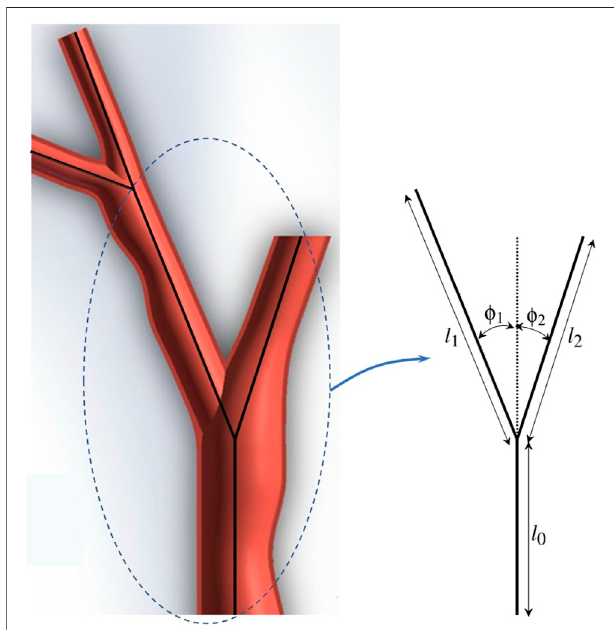
FIGURE 10 | Fractal tree modeling of the vascular